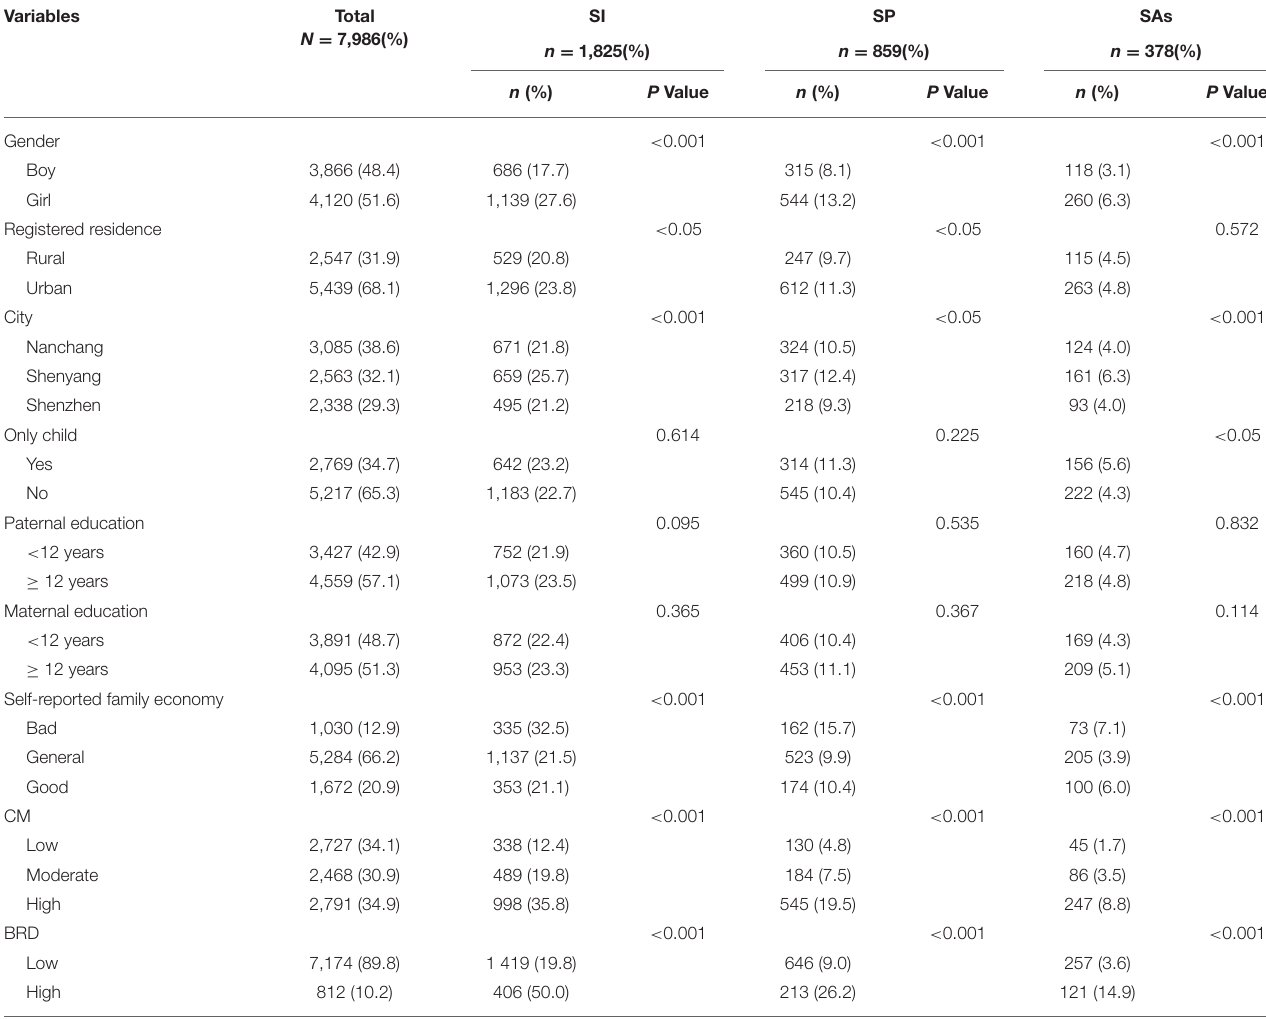
TABLE 1 | Descriptive statistics for